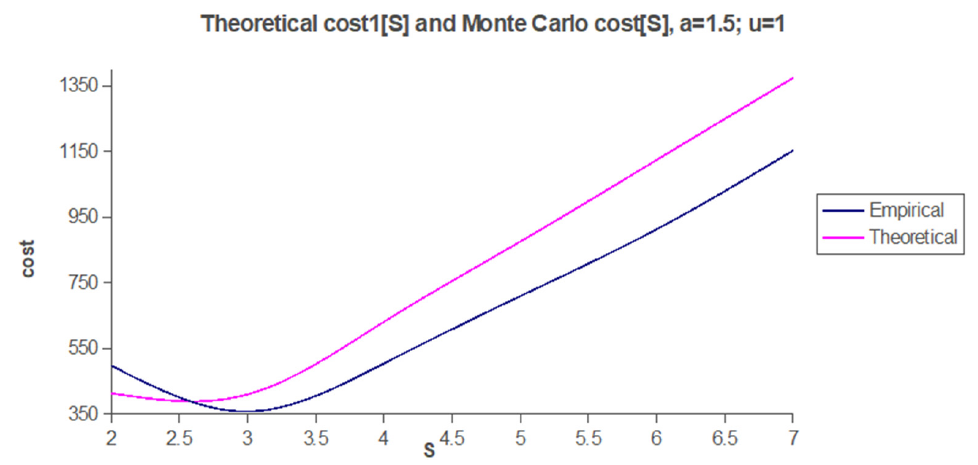
Figure A1. Theoretical cost and Monte Carlo cost in terms of S.